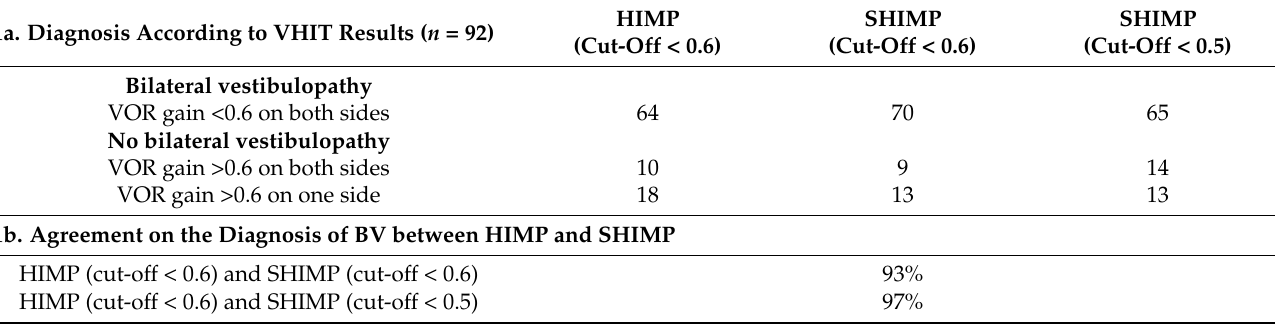
Table 1. Diagnosis of BV using HIMP and SHIMP (1a), and agreement between both paradigms